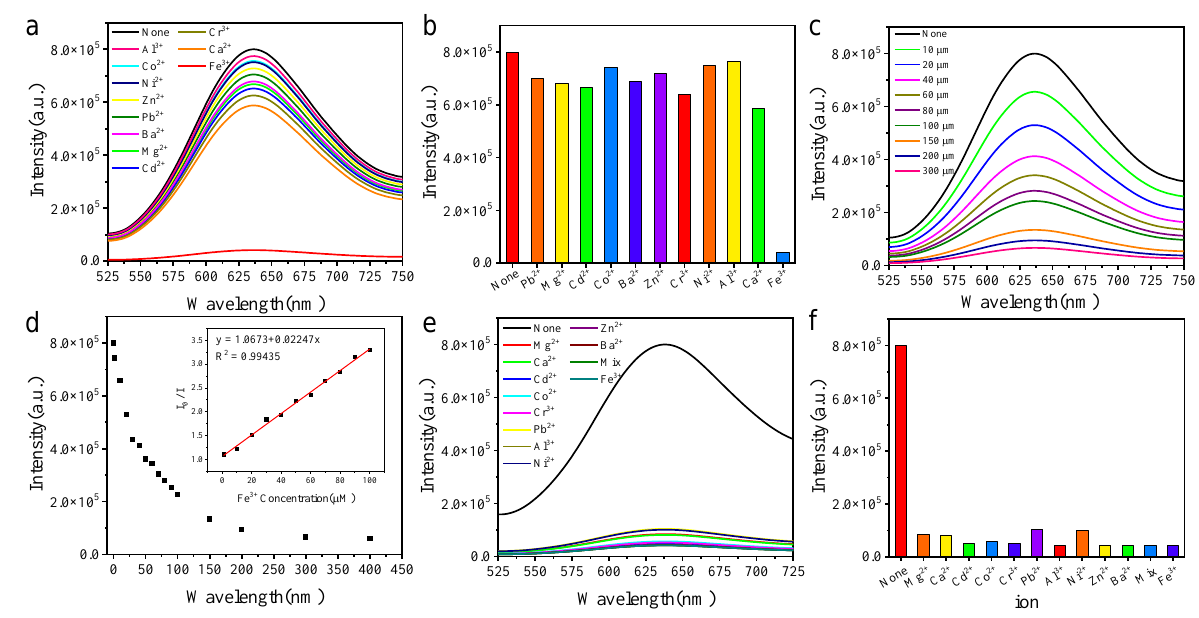
Figure 5. ( a ) Luminescence emission spectra and ( b ) luminescence intensities at 640 nm for 0.3% Ag 9 -NCs/L–MA xero- gel/PMMA film in different cations. ( c ) Luminescence emission spectra and ( d ) luminescence intensities at 640 nm for 0.3% Ag 9 -NCs/L–MA xerogel/PMMA film in Fe 3+ with different concentrations. The insert of d shows Stern–Volmer quenching curve of the luminescence intensity of 0.3% Ag 9 -NCs/L–MA xerogel/PMMA film at 640 nm against Fe 3+ concentration; ( e ) luminescent emission spectra and ( f ) luminescence intensities at 640 nm for 0.3% Ag 9 -NCs/L–MA xerogel/PMMA film in solutions of different cations with Fe 3+ .